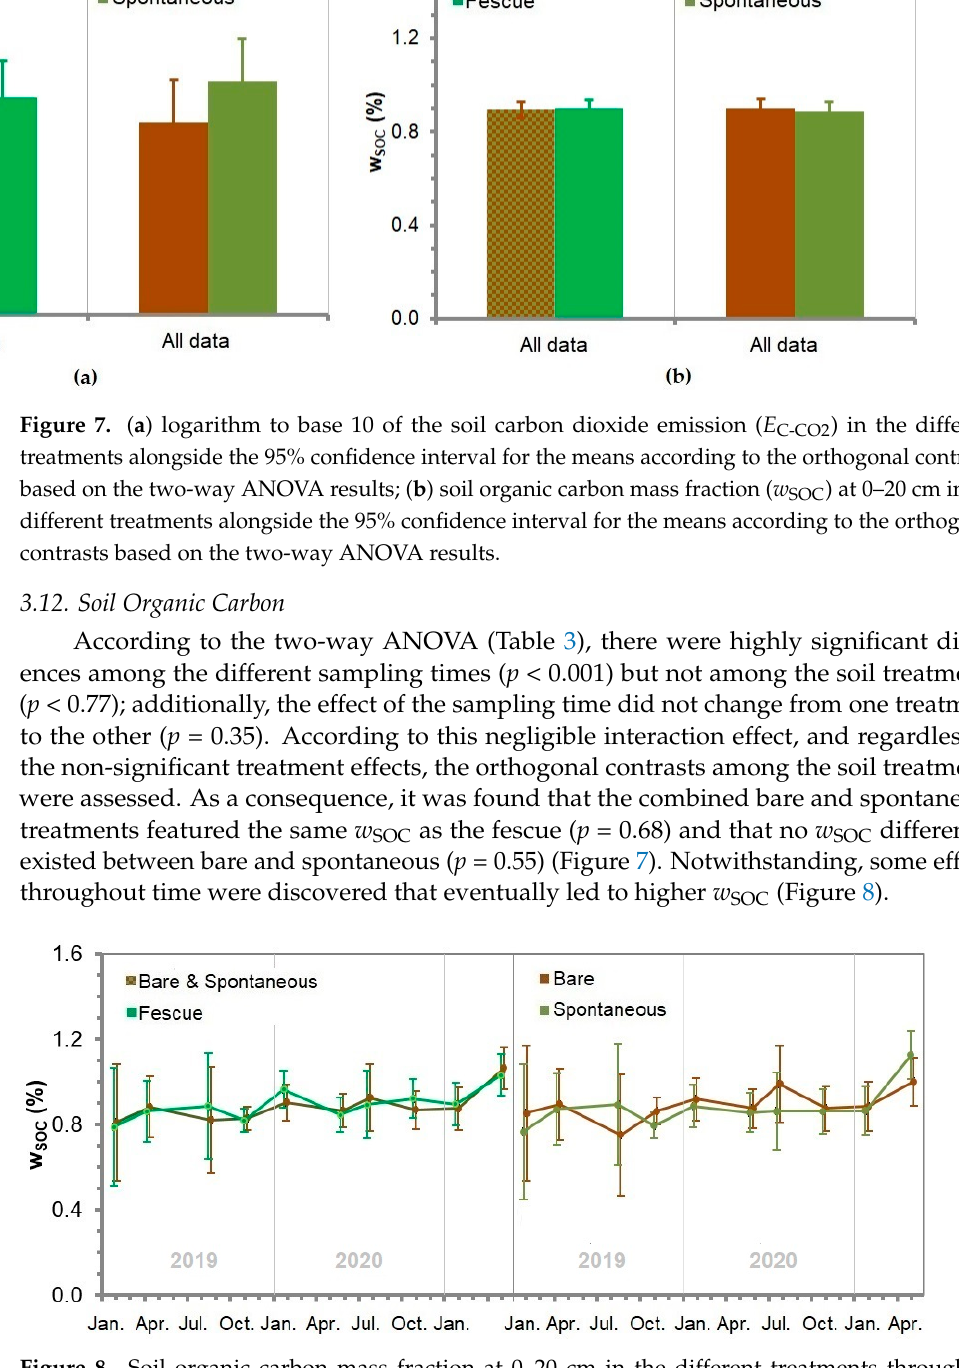
Figure 8. Soil organic carbon mass fraction at 0–20 cm in the different treatments throughout all sampling dates during the monitoring time alongside the respective 95% confidence intervals according to the orthogonal contrasts based on the one-way ANOVAs results.